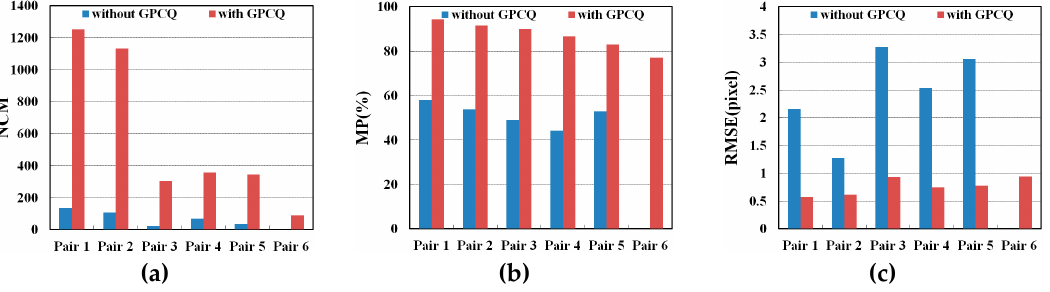
Figure 12. Comparison of ( a ) NCM, ( b ) MP, and ( c ) RMSE with and without GPCQs.